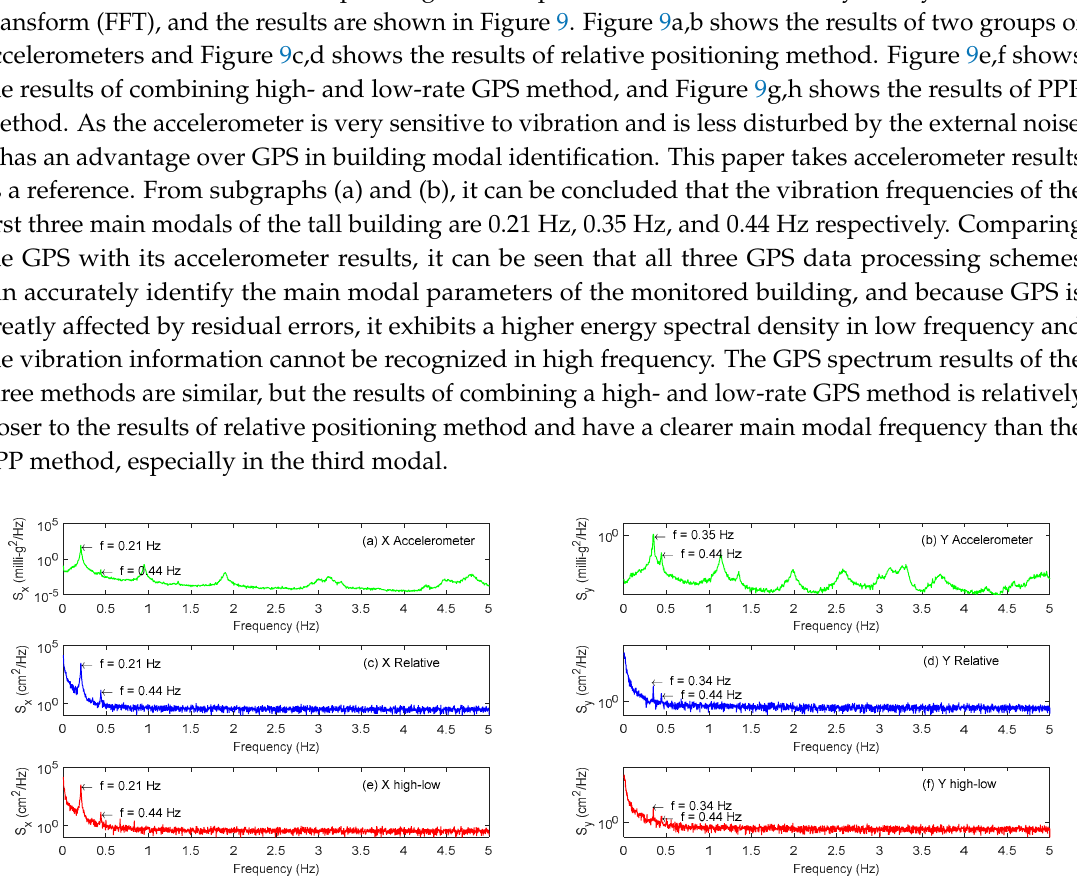
( c ) Figure 10. Spectrum of GPS displacement time history (0~1 Hz band) in the X direction: ( a ) relative positioning method, ( b ) combining high- and low-rate GPS method, and ( c ) PPP method. In order to obtain the first modal wind-induced vibration displacement of the building, the sym25 (sym 2 by 5) wavelet packet of MATLAB (MathWorks, Natick, MA, USA) is used to decompose the GPS data into 5 levels, and the data in the frequency band (0.15625~0.3125 Hz) is